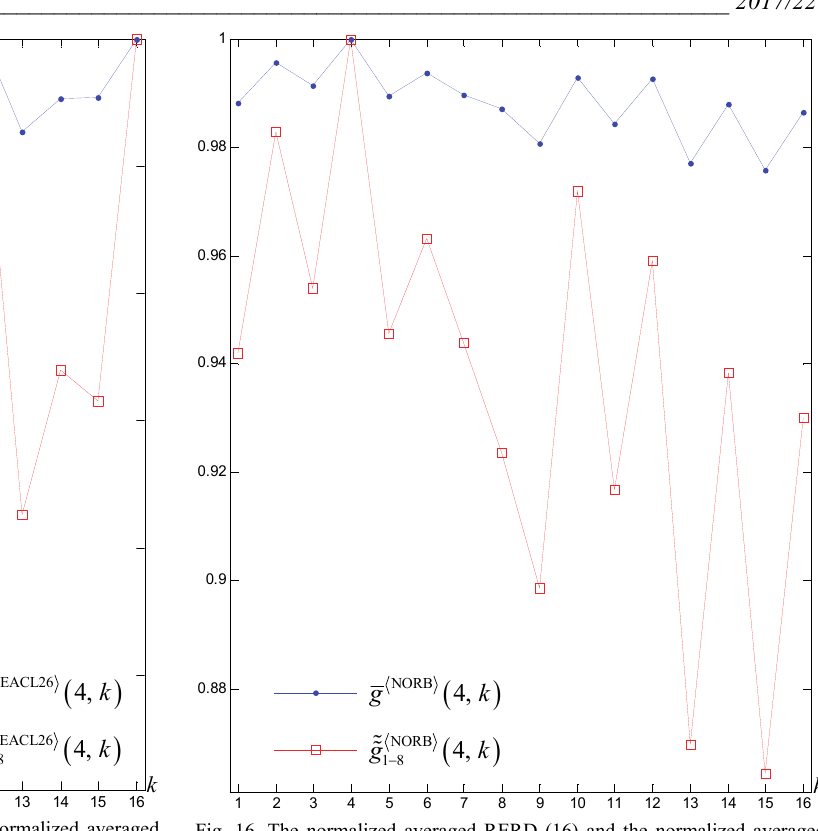
Fig. 16. The normalized averaged RERD (16) and the normalized averaged 4 N  on NORB. Maxima coincide at k = 4. final-epoch RERD (17) by ConvL